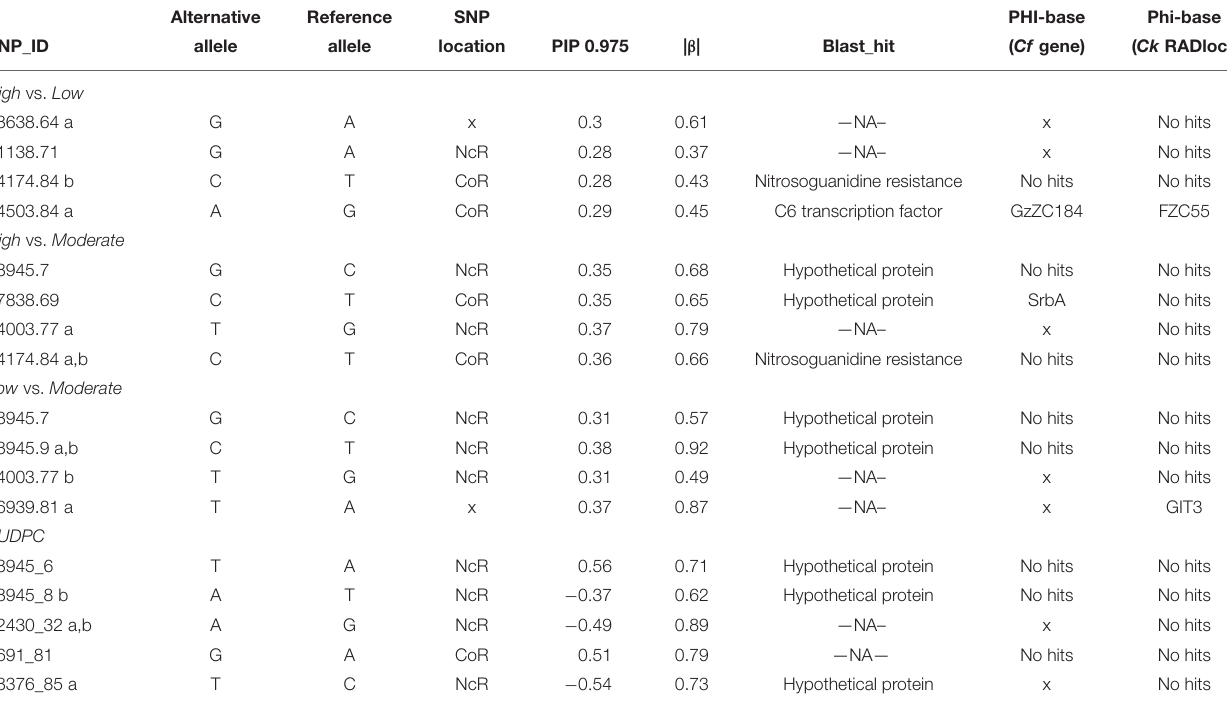
TABLE 2 | SNPs associated with aggressiveness for each pairwise comparison ( High vs. Moderate , High vs. Low , Low vs. Moderate ) and for the continuous analyses ( AUDPC ) obtained through multi-SNP association tests using Bayesian regression approach. Alternative Reference SNP PHI-base